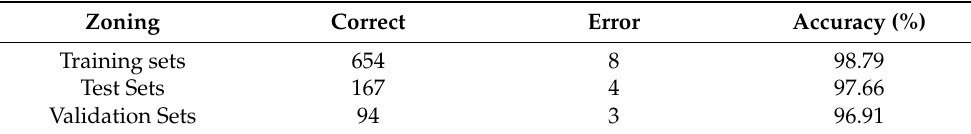
Table 3. Classification results of sinus bradycardia image recognition model.